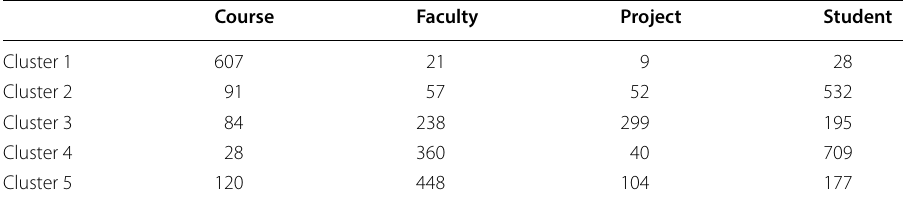
Table 11 The category distribution in clusters generated by euclidean (webkb, tf-normal) Course Faculty Project Student Cluster 1